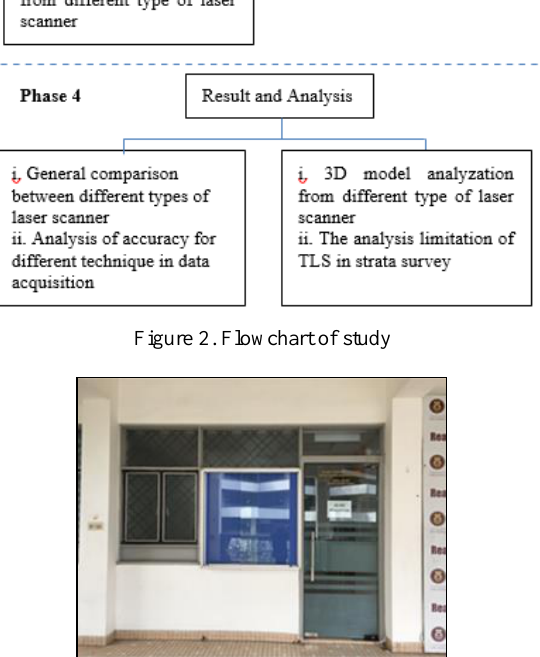
Figure 3. Area of